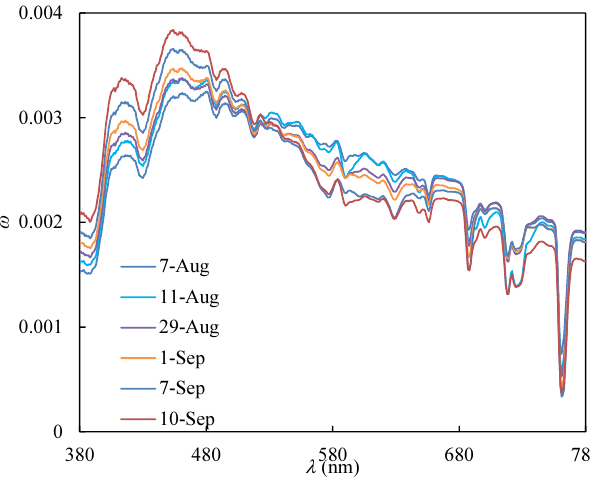
Figure 6. Normalized values of incident solar radiation under dif- ferent sky conditions, defined as the ratio of the spectrum in Fig. 5a to the total energy in the visible